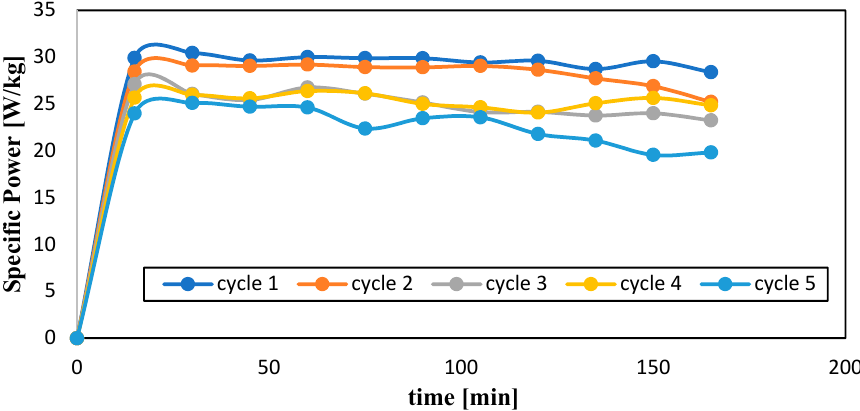
Figure 8. Comparison of power generated at a given time for all cycles.